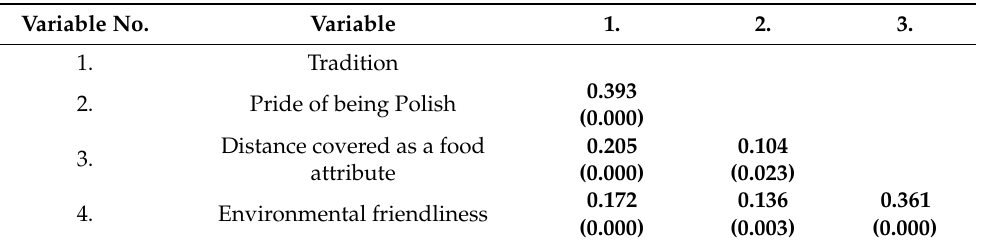
Table 8. Correlation matrix for predictors of consumer ethnocentrism in the food market used in the retrograde stepwise regression model among